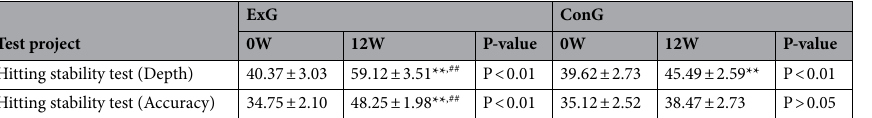
Table 7. Comparative analysis of subjects’ batting stability test results. Within-group differences *P < 0.05, **P < 0.01; Differences between groups # P < 0.05, ## P <